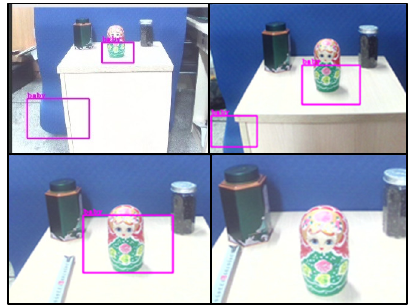
Figure 20. Image of recognition situation.